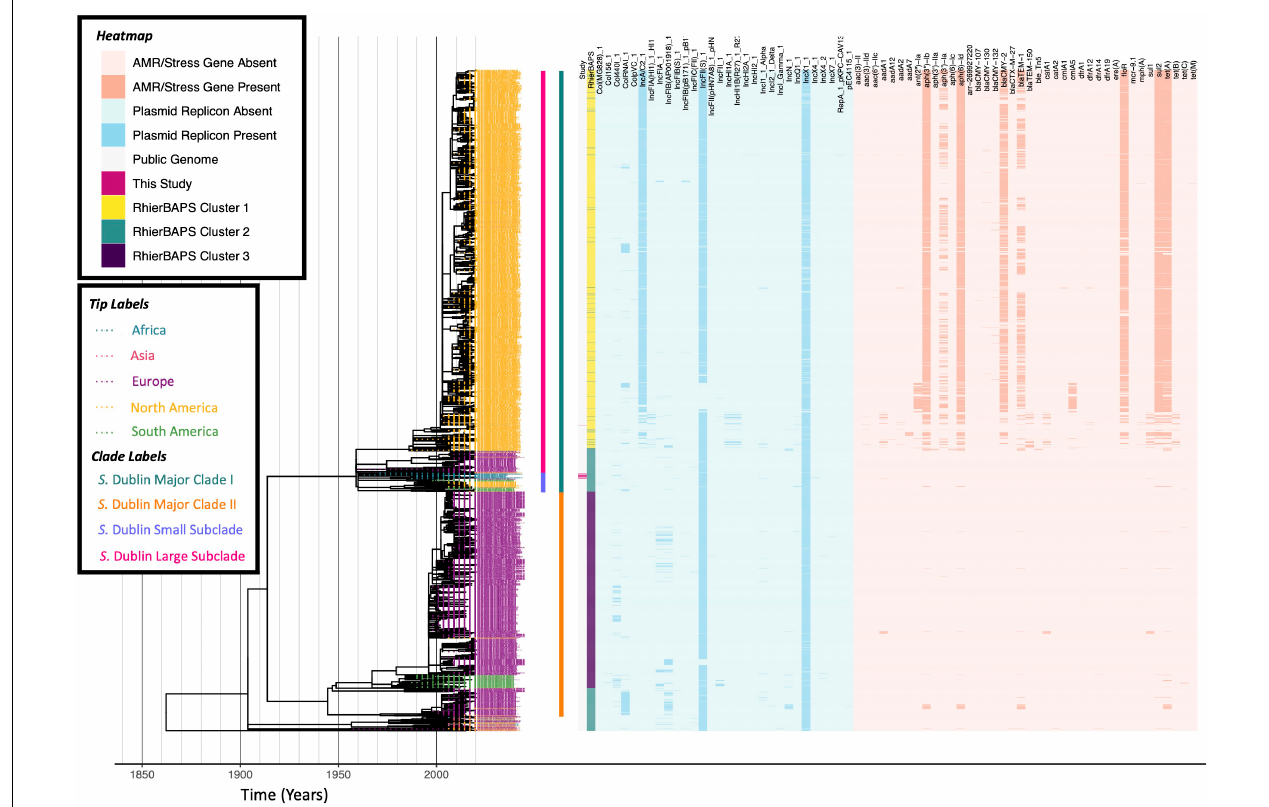
FIGURE 3 | Maximum likelihood phylogeny constructed using core SNPs identified among 2,802 S. Dublin genomes (2,784 publicly available genomes, plus 18 sequenced here). Tip label colors denote the continent from which each strain was reported to have been isolated. Clade labels denote major clades assigned in this study and are shown to the right of tip labels. The heatmap to the right of the phylogeny denotes: (i) whether an isolate was sequenced in conjunction with this study (dark pink) or not (gray; “Study”); (ii) level 1 cluster assignments obtained using RhierBAPS (“RhierBAPS”); the presence and absence of (iii) plasmid replicons (blue) and (iv) antimicrobial resistance (AMR) determinants (orange). The phylogeny was rooted and time-scaled using LSD2, with branch lengths reported in years ( X -axis). Core SNPs were identified among all genomes using Parsnp. AMR determinants were identified using ABRicate, the NCBI AMR determinant database, and minimum identity and coverage thresholds of 75 and 50%, respectively. Plasmid replicons were identified using ABRicate and the PlasmidFinder database, using minimum identity and coverage thresholds of 80 and 60%, respectively. The phylogeny was constructed and annotated using IQ-TREE and bactaxR/ggtree,